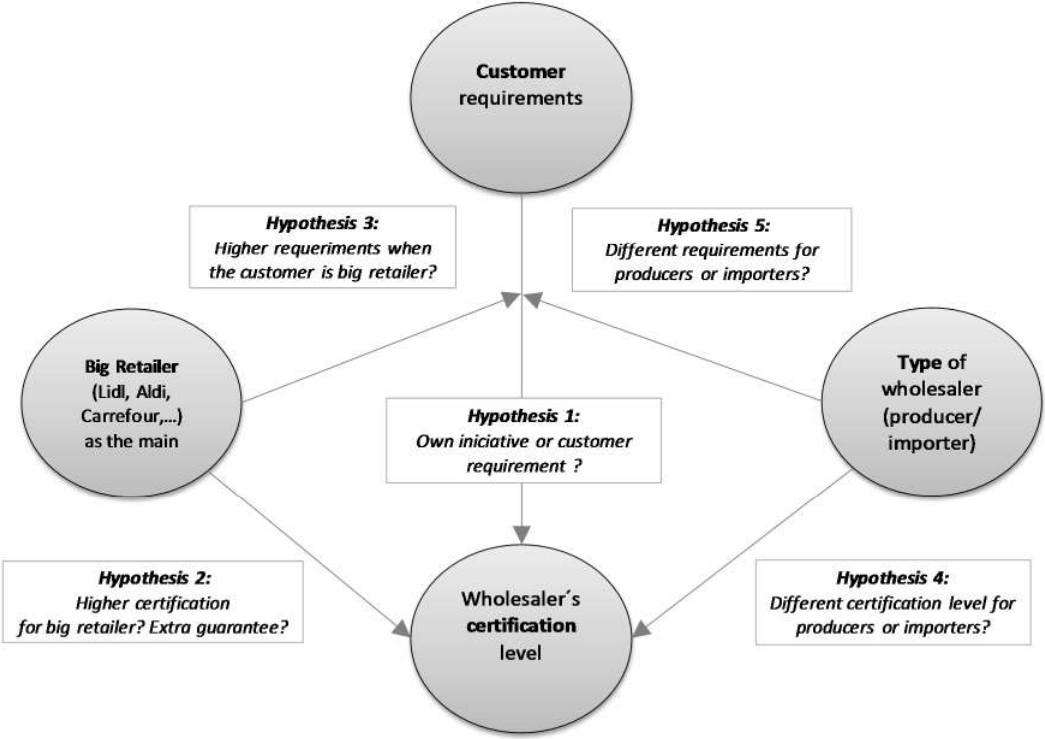
Figure 2. Tested relationships.